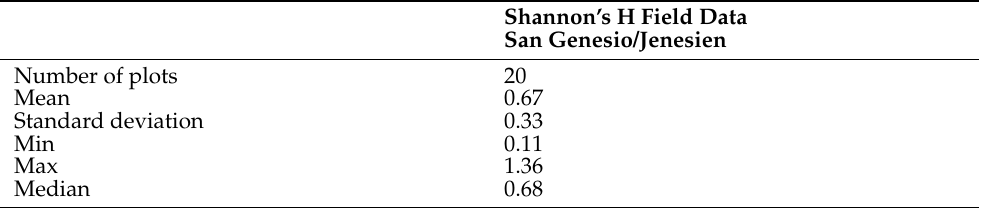
Table 4. Species diversity information derived from field data related to the whole study area. Further information related to the single plot can be found in Table